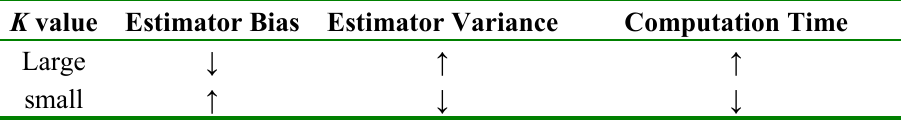
Table 3. Large K versus small K.